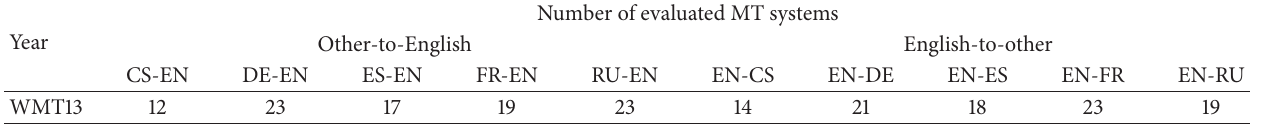
Table 9: The performances on WMT13 shared tasks using Spearman rank correlation. Correlation score with human System